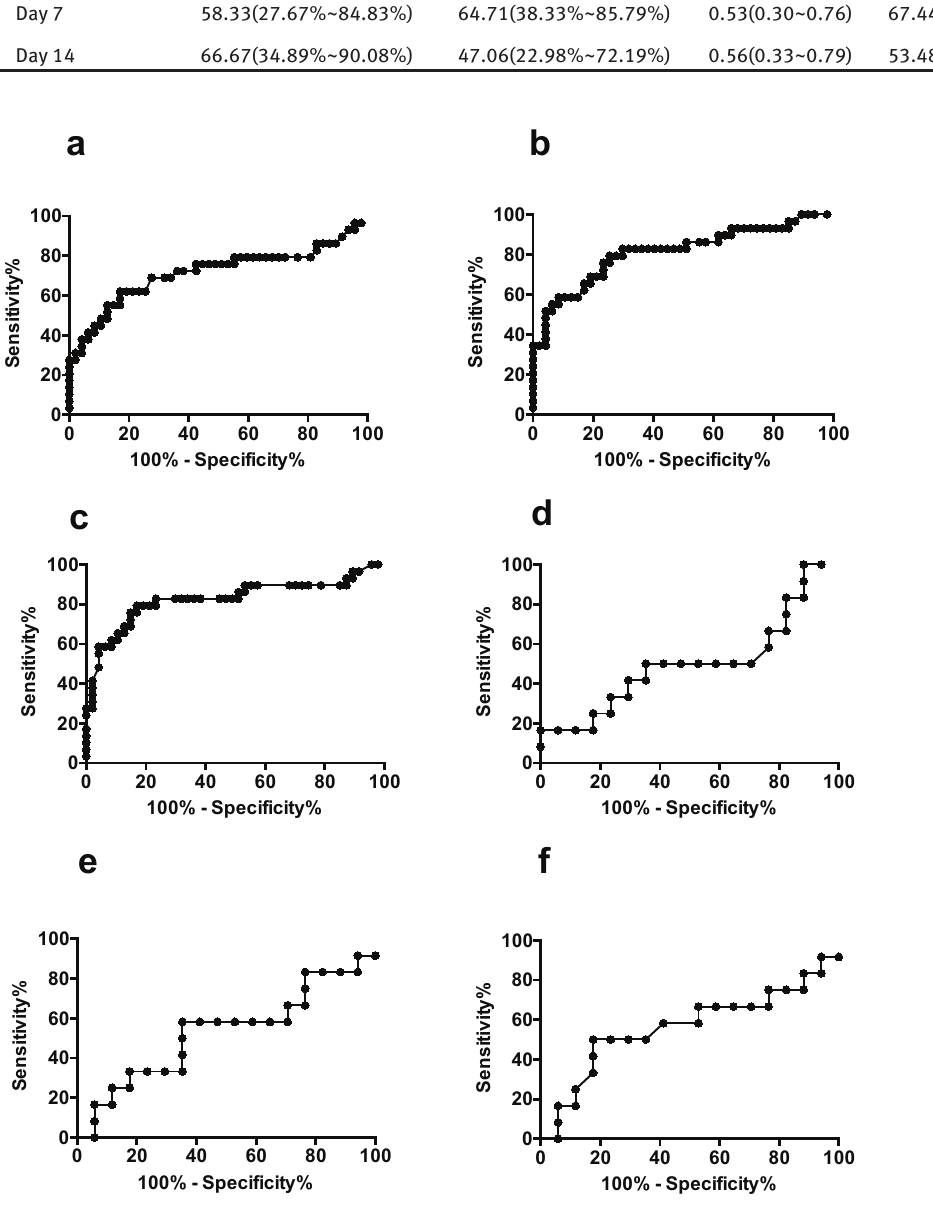
Figure 3: ROC curve of serum neopterin for (MODS) and death [(roc curve for diagnosis of MODS by serum neopterin on PBDs 3(a), PBDs 7 (b), and PBDs 14(c); roc curve for prediction death by serum neopterin on PBDs 3(d), PBDs 7 (e), and PBDs 14(f)].